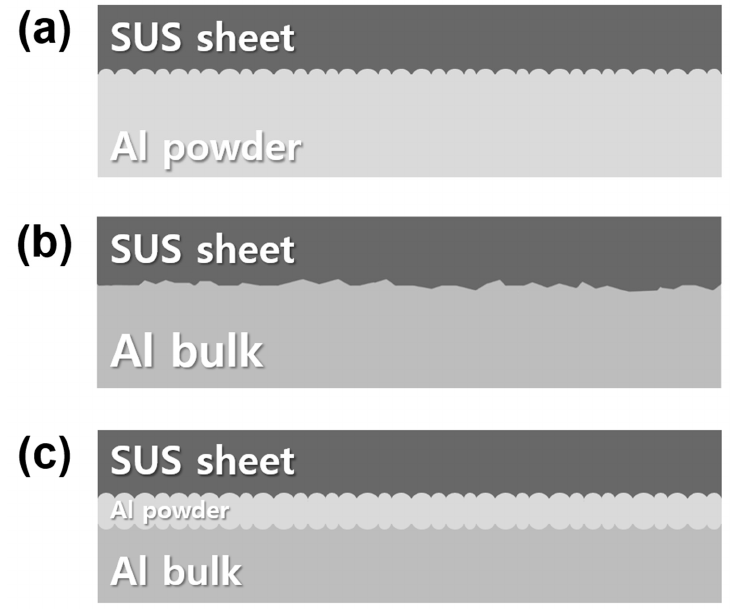
Figure 7. Schematic diagrams of interface layers between Al and SUS matrix: ( a ) P/B, ( b ) B/B, and ( c ) B/P/B clads.